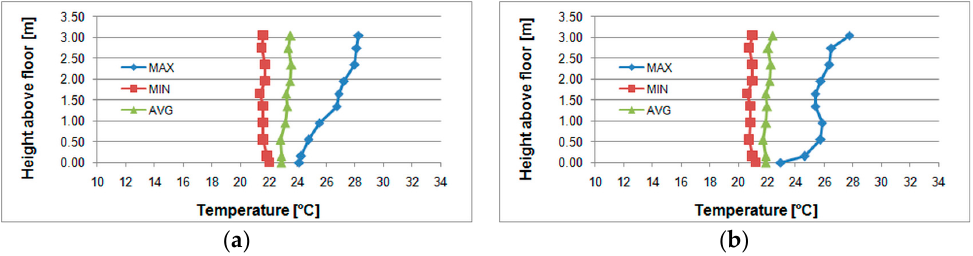
Figure 8. Vertical profile of internal air temperature: ( a ) during the hottest week; ( b ) during the coldest week.